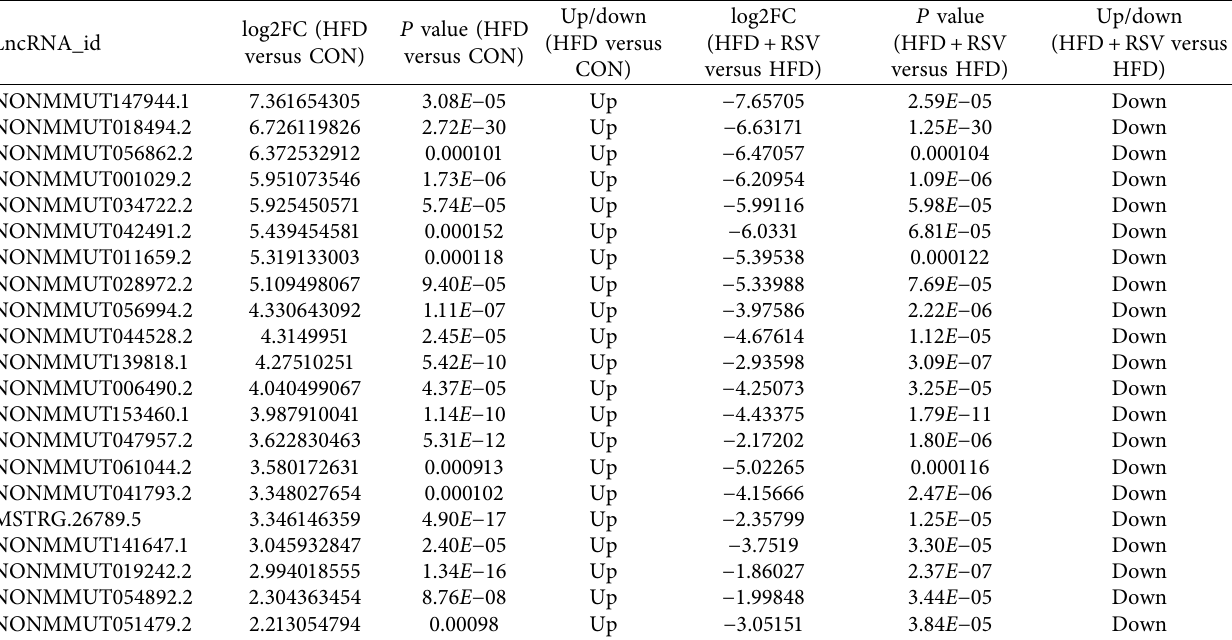
Figure 2: Profiles of differentially expressed genes in the three groups. Hierarchical clustering of lncRNAs (a) and mRNAs (b). Upregulated and downregulated lncRNAs (or mRNAs) are indicated in red and blue. Table 3: Top 30 significantly differentially expressed lncRNAs in